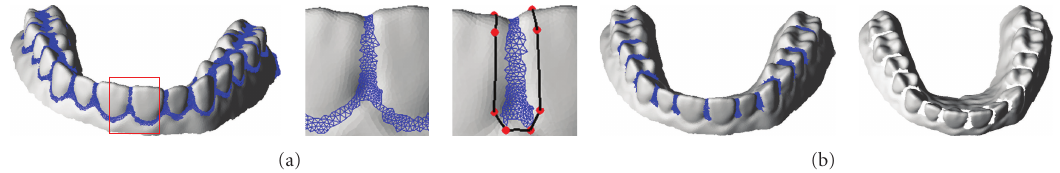
Figure 7: (a) Fusion region extraction example by using the spatial polygon selection method; (b) Results of the fusion regions being extracted and